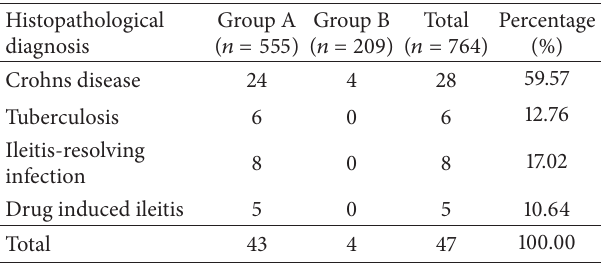
Table 2: Histopathological abnormalities of the ileum in Group A and Group